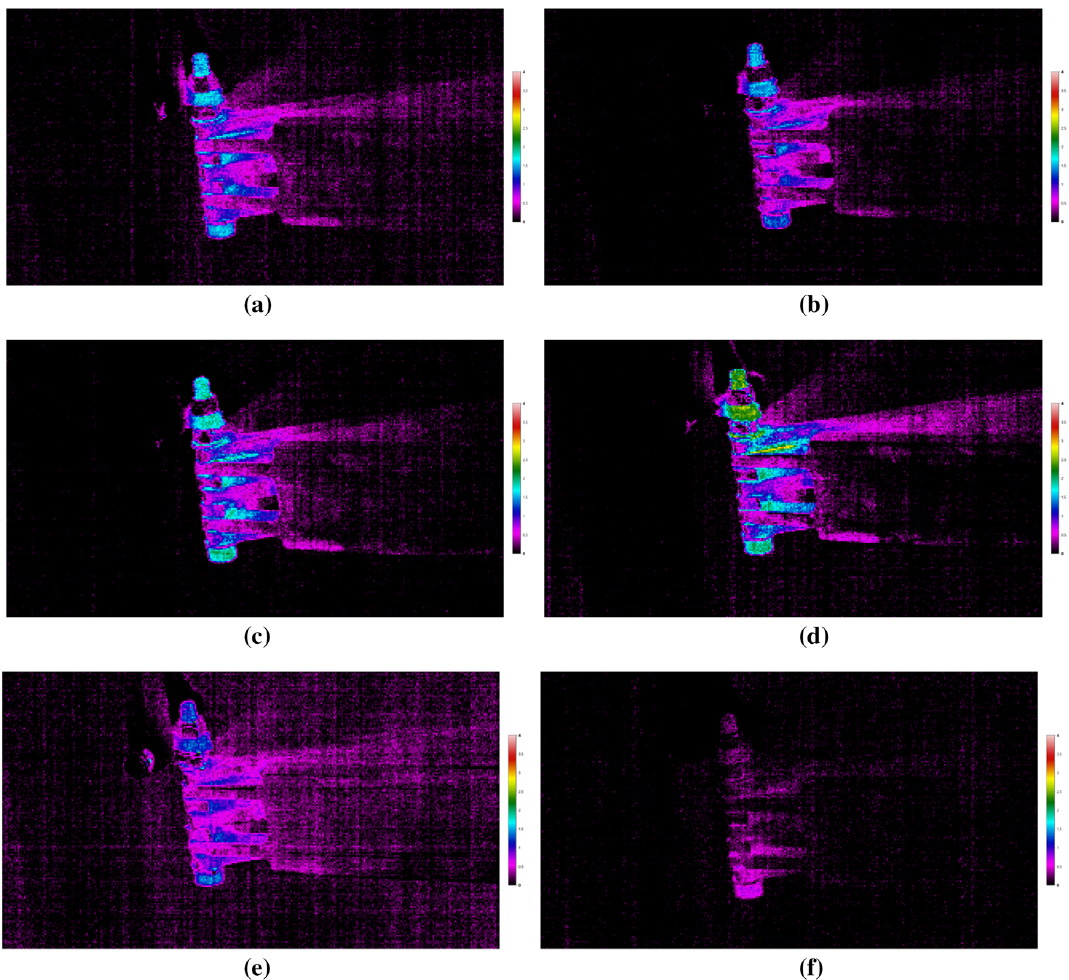
Fig. 17 The first snapshots from the six tests, sorted in descending order by bolt load ( a – f 6.0 Nm, 4.5 Nm, 3.0 Nm, 1.5 Nm, 0.5 Nm and 0